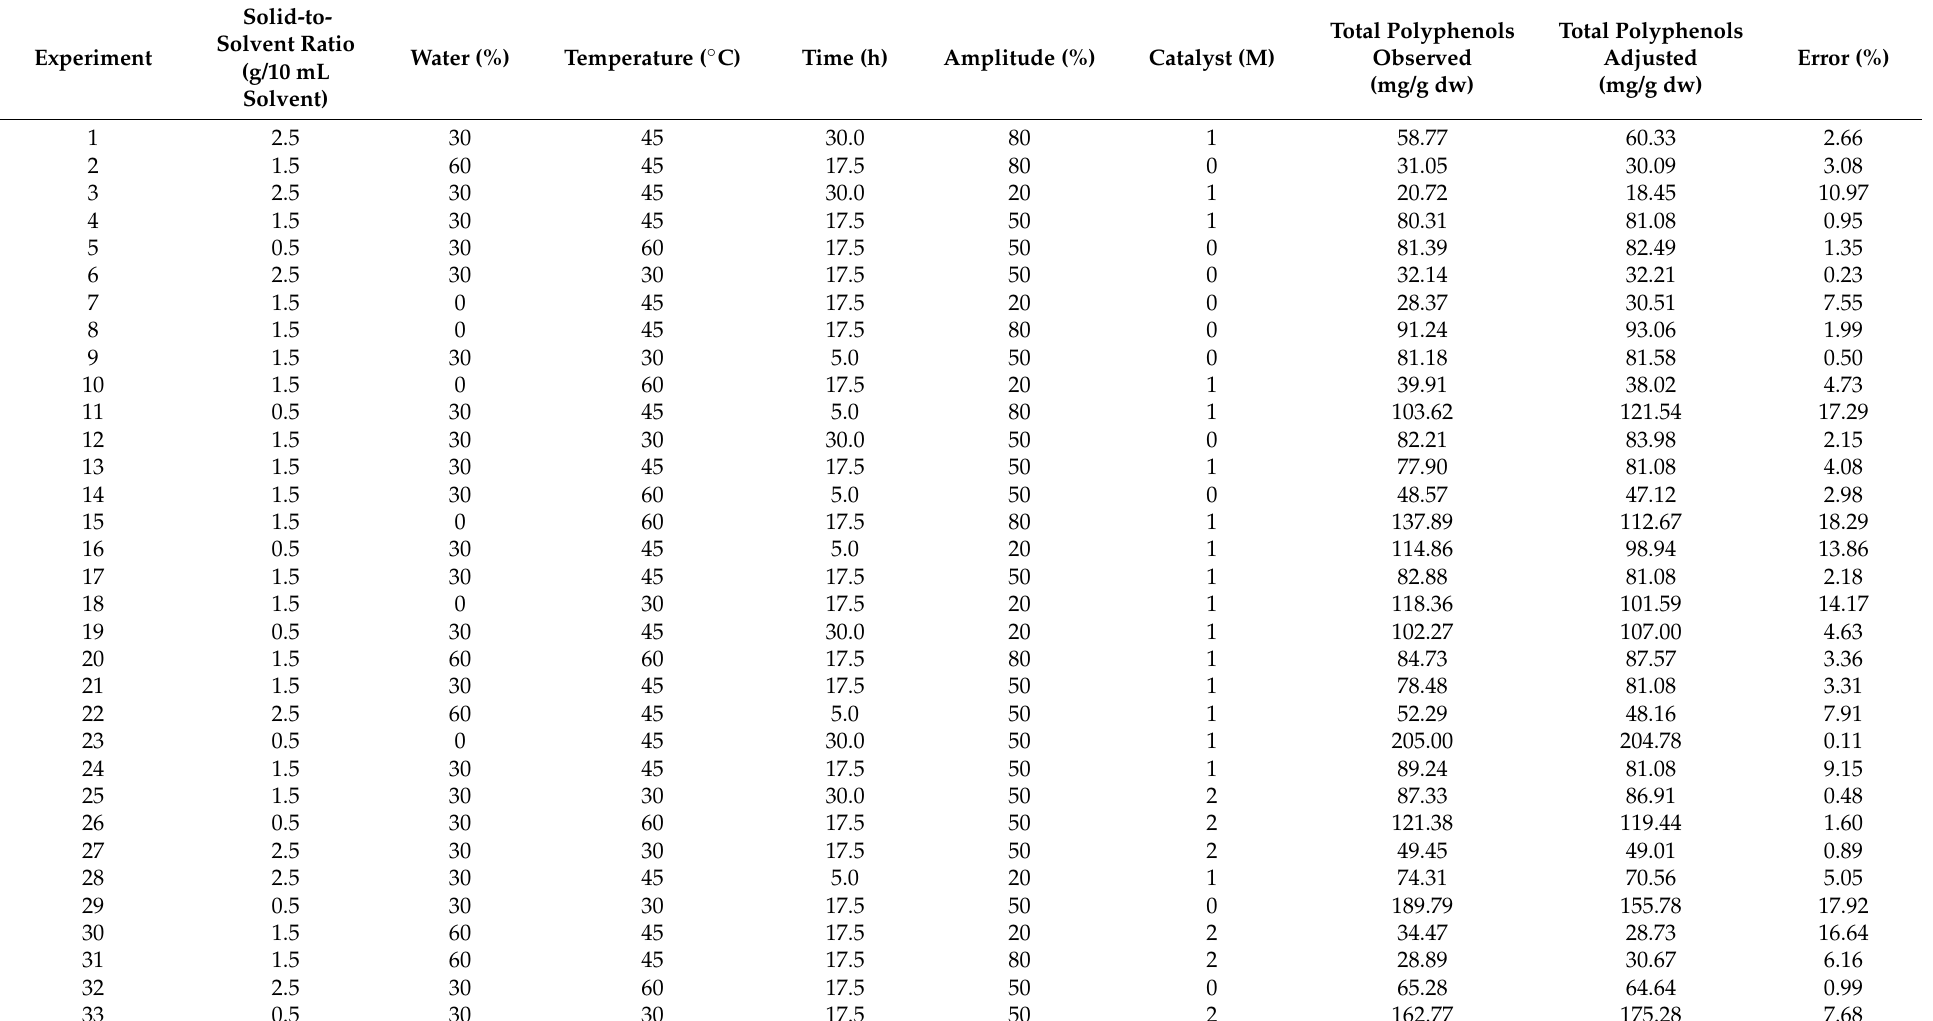
Table 1. Box–Behnken design conditions used for the optimization of the USE-based extraction of polyphenols from pine needles.